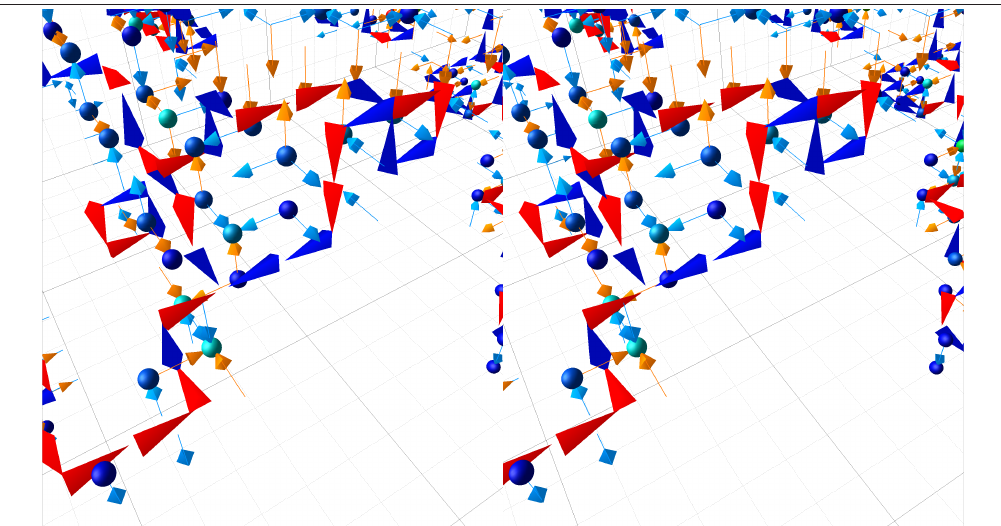
Figure 3. Stereoscopic image of centre vortices as identified on the lattice. Vortex features includ- ing vortex lines (jets), branching points (3-jet combinations), crossing points (4 jets), indicator links (arrows) and singular points (spheres) are described in the